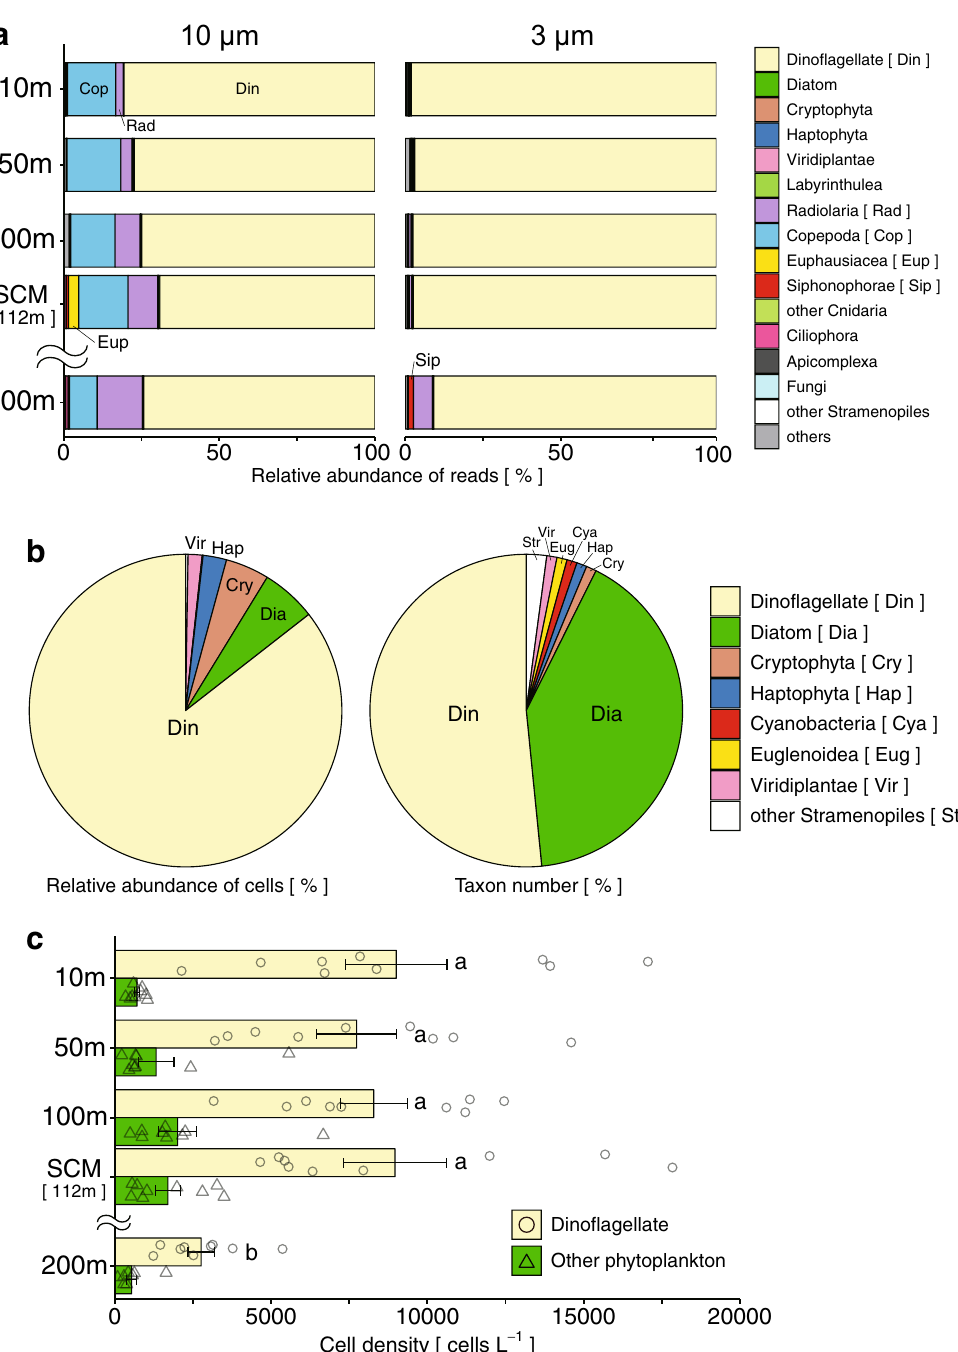
Figure 8. Eukaryotic composition in POM of seawater. Average relative abundances of eukaryotic reads from NGS analysis with two filter size groups (10 and 3 μm, respectively; 43 samples each) at five depth layers from nine stations ( a ). Overview of phytoplankton composition and numbers of taxa (> 2 µm) obtained by cell counting of 45 samples at the same five depth layers and same nine stations for NGS analysis of POM ( b ). Average phytoplankton composition at five depth layers in nine stations ( c ). Letters indicate significantly different mean values ( p < 0.01) ( c ). Other phytoplankton composing of seven taxonomic groups excluding dinoflagellates did not show significant differences among the layers ( c ). The mean depth of the SCM is 112 m. Error bars in c indicate standard errors of the mean. Data are available in Supplementary Table